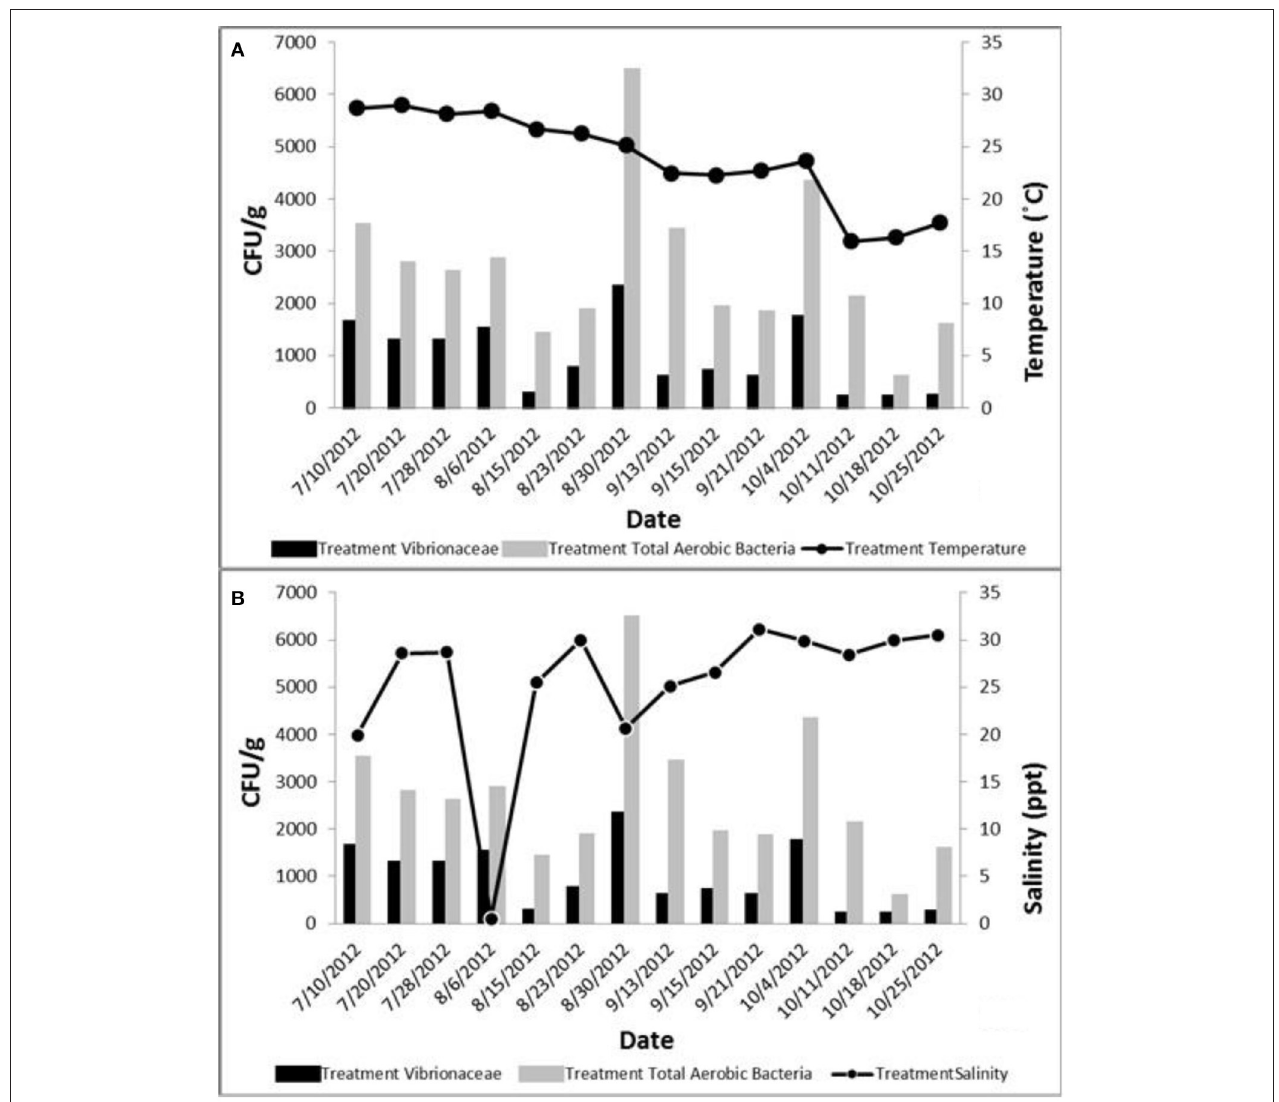
FIGURE 6 | (A) Total aerobic bacteria and Vibrionaceae levels in relation to the temperature (Hannum, 2007). (B) . Total aerobic bacteria and Vibrionaceae levels in relation to water salinity (Hannum, 2007).